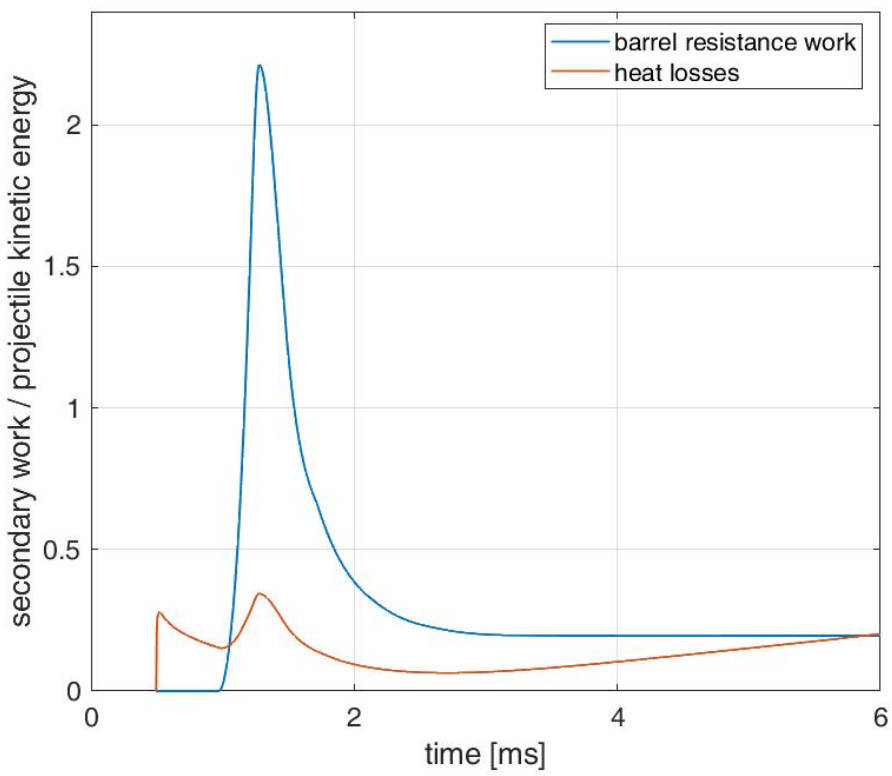
Figure 19. The courses of the relation of secondary works to the projectile kinetic energy as function of time.